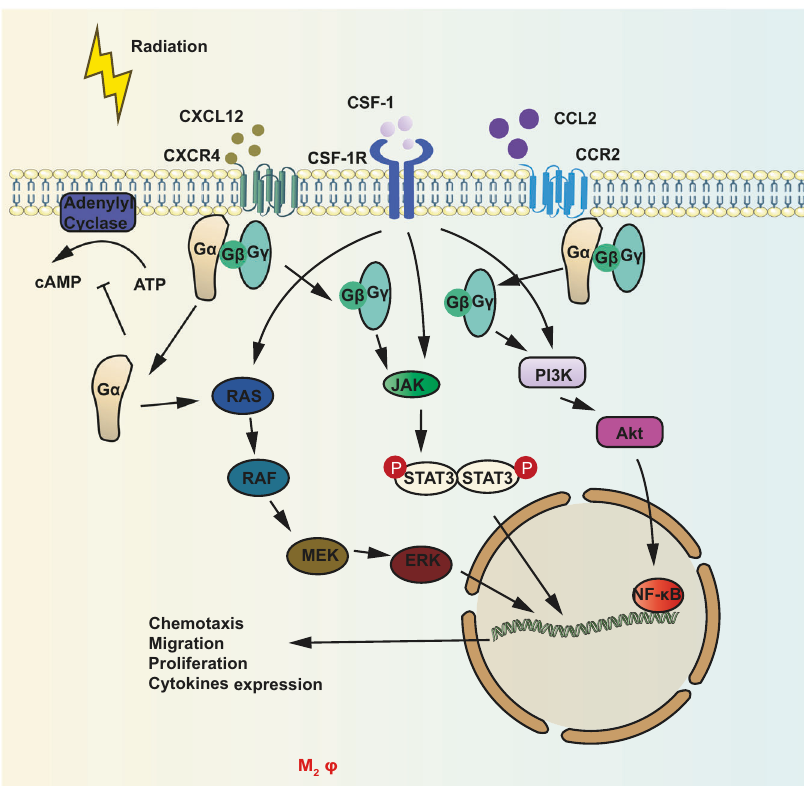
Fig. 5 Signaling pathways of radiation on TAMs. Radiation increases the level of CXCL12 which then binds to CXCR4, a kind of G-protein- coupled receptor (GPCR). Similarly, CCL2 and its receptor, CCR2 are also activated by radiation. Next, the receptor undergoes a second conformational change that activates the intracellular trimeric G protein by the dissociation of G α subunit from the G β /G γ dimer. Then, the phosphatidylinositide 3-kinases (PI3Ks) can be activated by both G β / γ and G α subunits. PI3Ks regulate gene transcription, migration, and adhesion of TAMs by the phosphorylation of AKT and of several focal adhesion components. In addition, G α subunit also activates the Ras and Rac/Rho pathways, leading to the phosphorylation of ERK. Activated ERK can phosphorylate and regulate other cellular proteins, as well as translocate into the nucleus and phosphorylate and regulate transcription factors, leading to migration, proliferation, and cytokines expression of TAMs. G β /G γ dimer also activates JAK/STAT signaling pathway to promote changes in cell morphology leading to chemotactic responses. Of note, CSF-1/CSF-1R activates all the three signaling pathways we discussed above. Parts of this fi gure were drawn with aid of Servier Medical Art (http://www.servier.com), licensed under a Creative Commons Attribution 3.0 Unported